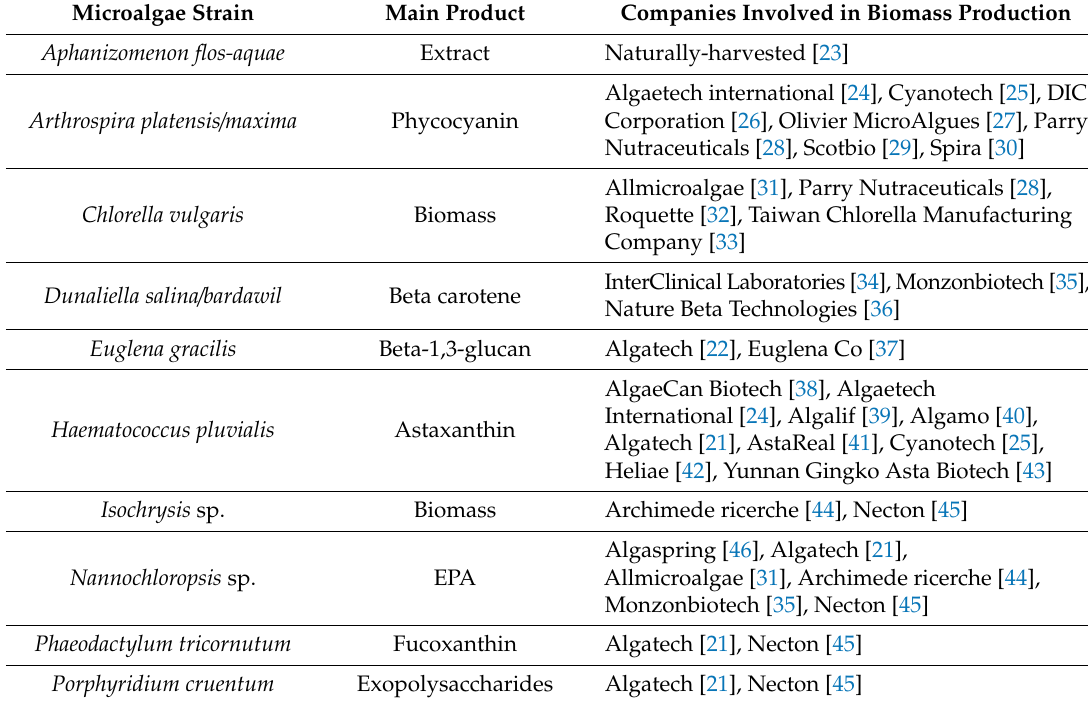
Table 1. Selection of microalgae companies producing